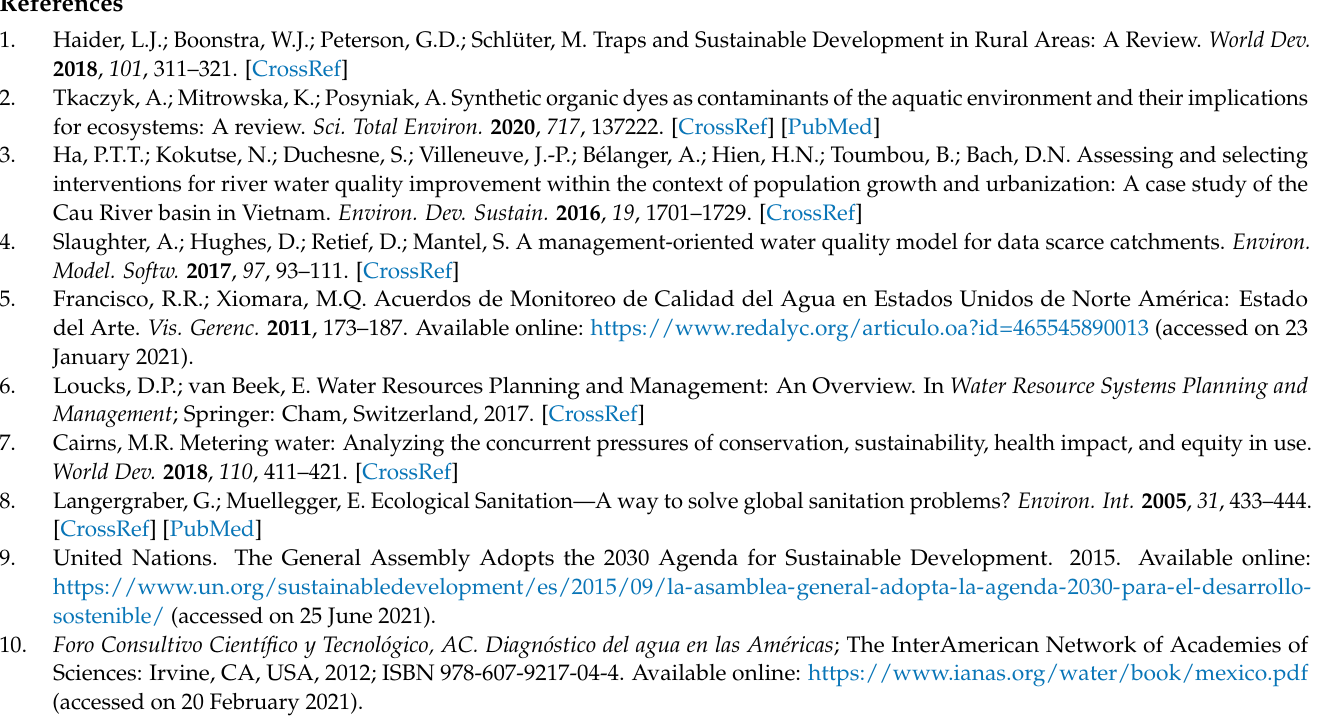
Median plot with 95% confidence intervals, Figure S11: 75 As [He]-MANOVA: Point and month interaction, Figure S12: ANOVA: point, Table S9: ANOVA for 75 As [He] per Plot, Figure S13: Median plot with 95% confidence intervals, Figure S14: ANOVA: month, Table S10: ANOVA for 75 As [He] per Month, Figure S15: Median plot with 95% confidence intervals, Figure S16: CONCENTRATION- MANOVA: metal an d month interaction, Table S11: ANOVA Table for CONC by METAL, Figure S17: Box plot, Figure S18: Median plot with 95% confidence intervals, Table S12: ANOVA table for CONC by Month, Figure S19: Box plot, Figure S20: Median plot with 95% confidence intervals, Table S13: ANOVA Table by 55 Mn [He] by pH, Figure S21: Box plot, Figure S22: Median plot with 95% confidence intervals, Table S14: ANOVA Table for 66 Zn [He] by pH, Figure S23: Box plot, Figure S24: Median plot with 95% confidence intervals, Table S15: ANOVA Table for 75 As [He] by pH, Figure S25: Box plot, Figure S26: Median plot with 95% confidence